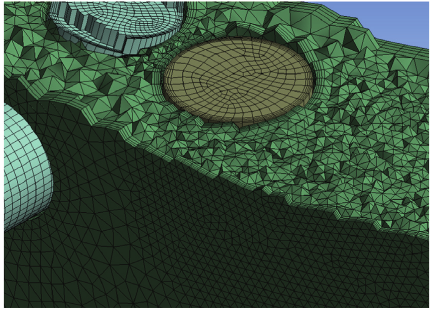
Figure 8: Detail of the mesh in the zone of